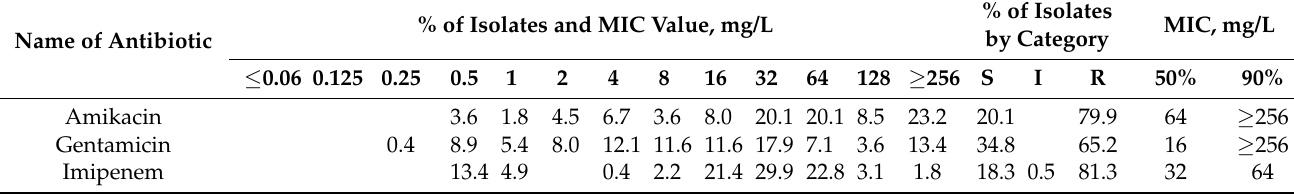
Table 1. Antibiotic sensitivity of A. baumannii isolates ( n = 224). % of Isolates and MIC Value, Name of Antibiotic